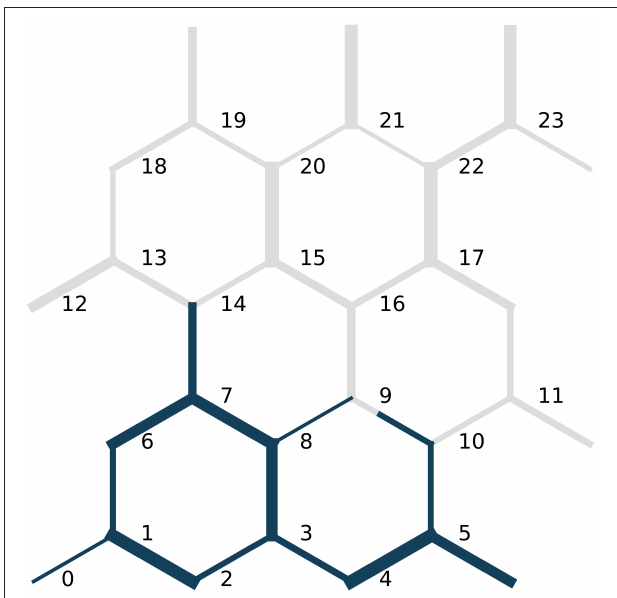
FIGURE 4 | Initial fluid configuration in the Haines jump case. The non-wetting fluid is blue while the wetting fluid is gray. The link radii are not drawn to scale with the link lengths. Node indices are indicated in black.